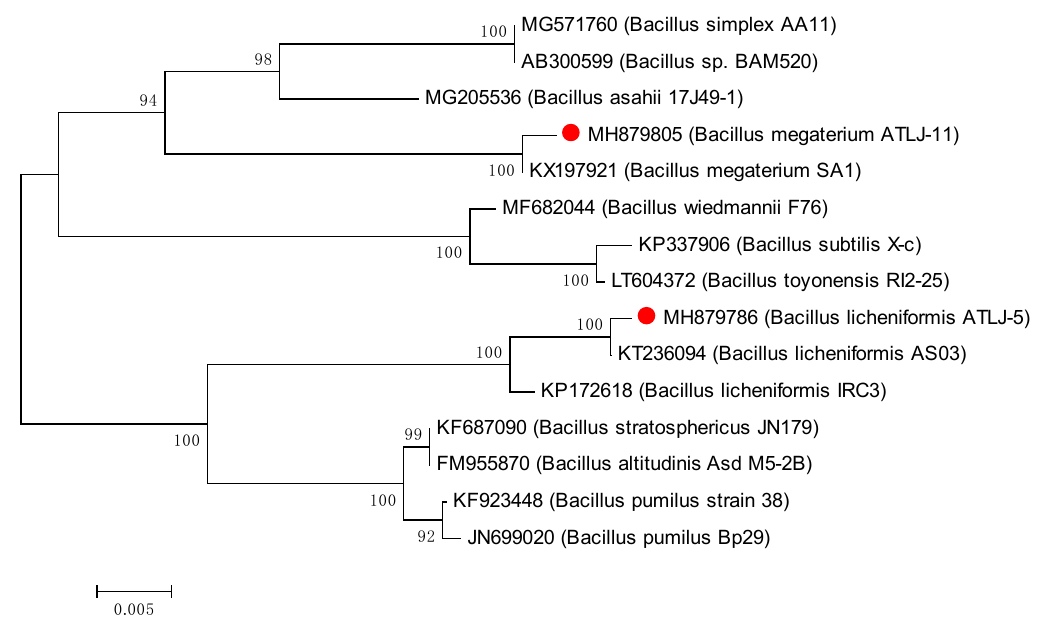
Figure 2. Phylogenetic tree of strain ATLJ-5 and strain ATLJ-11.